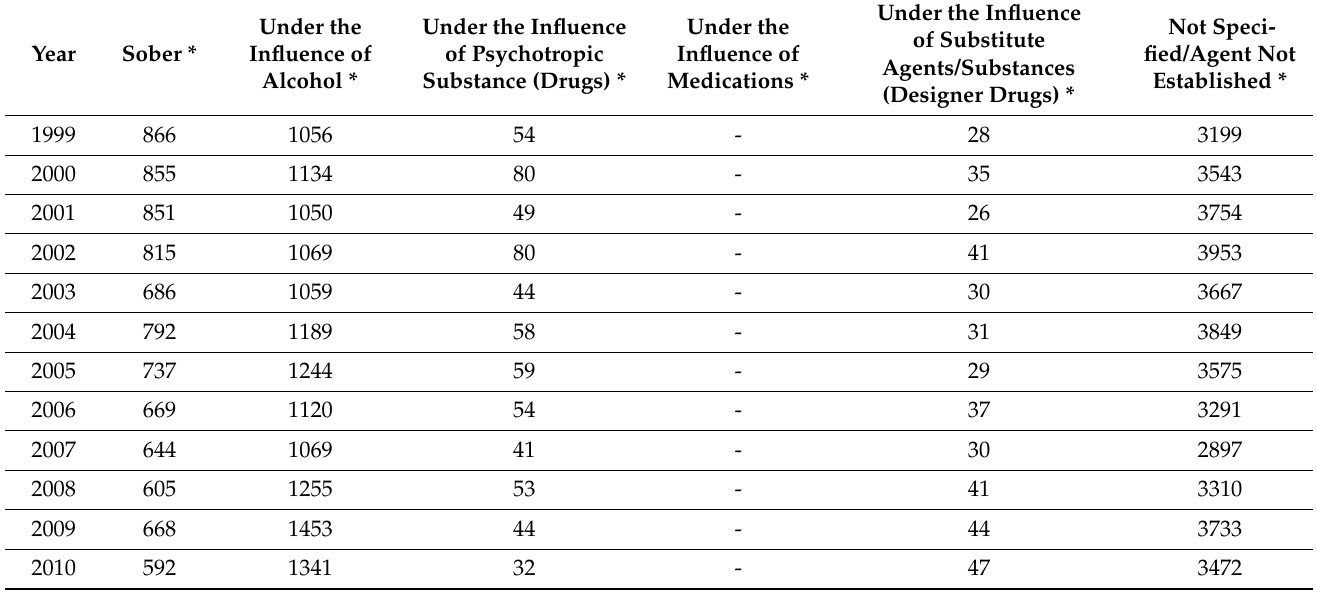
Table 3. Suicide attempts depending on the state of consciousness (source: own study based on data by